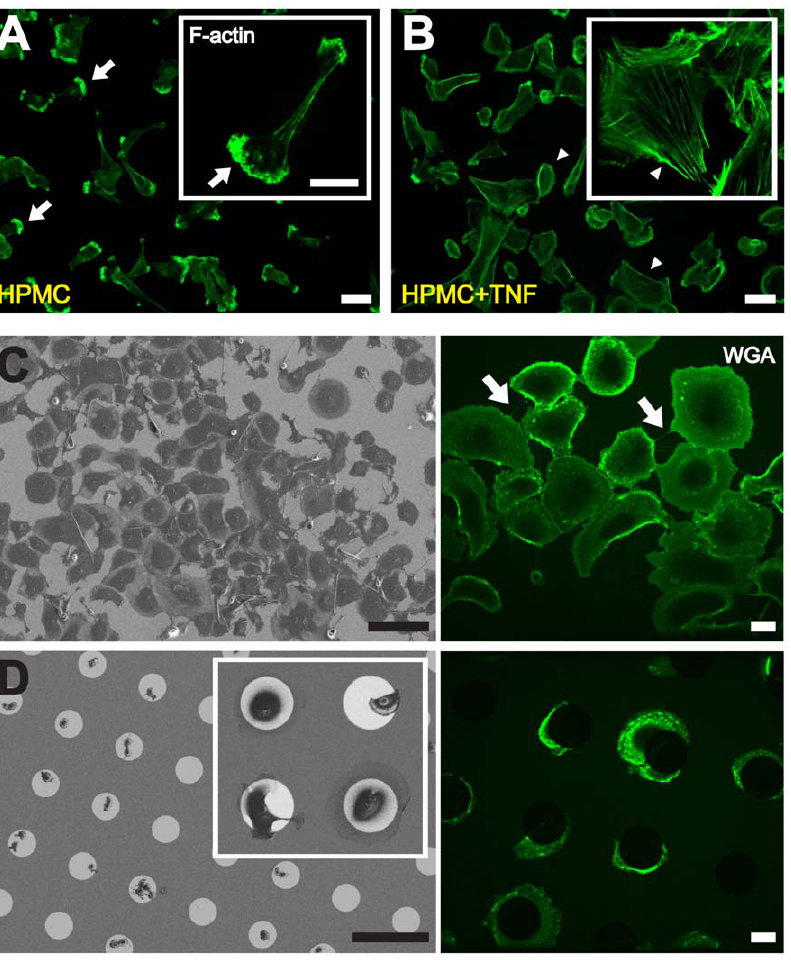
Figure 2. (A, B) Influence of TNF- a on actin cytoskeleton reorganization in HPMCs. ( A ) The fluorescence picture shows a predominant localization of F-actin at the rim of the cells (arrows) in absence of TNF- a . ( B ) The presence of TNF- a leads to reorganization of the actin cytoskeleton accompanied by the formation of actin stress fibers (arrowheads). Scale bars: 50 m m. ( C , D ) Spatial separation of HPMCs results in complete inhibition of NT formation. ( C ) Scanning electron and live-cell fluorescence microscopy pictures of HPMCs one hour after plating on homogeneously collagen I coated glass cover slides. The white arrows point to NTs spanned between the cells. Scale bars (left): 100 m m; (right): 20 m m. ( D ) HPMCs seeded on IKVAV functionalized (50 m M) microstructured surfaces with a gold disk diameter and spacing of 50 m m. Scanning electron microscopy (left panel) and live- cell imaging analyses (right panel) were performed one hour after plating. Note that cells exclusively attach to the biofunctionalized gold disk structures. The inserts in A, B and D represent higher magnified images. Scale bars (left): 100 m m; (right): 20 m m.